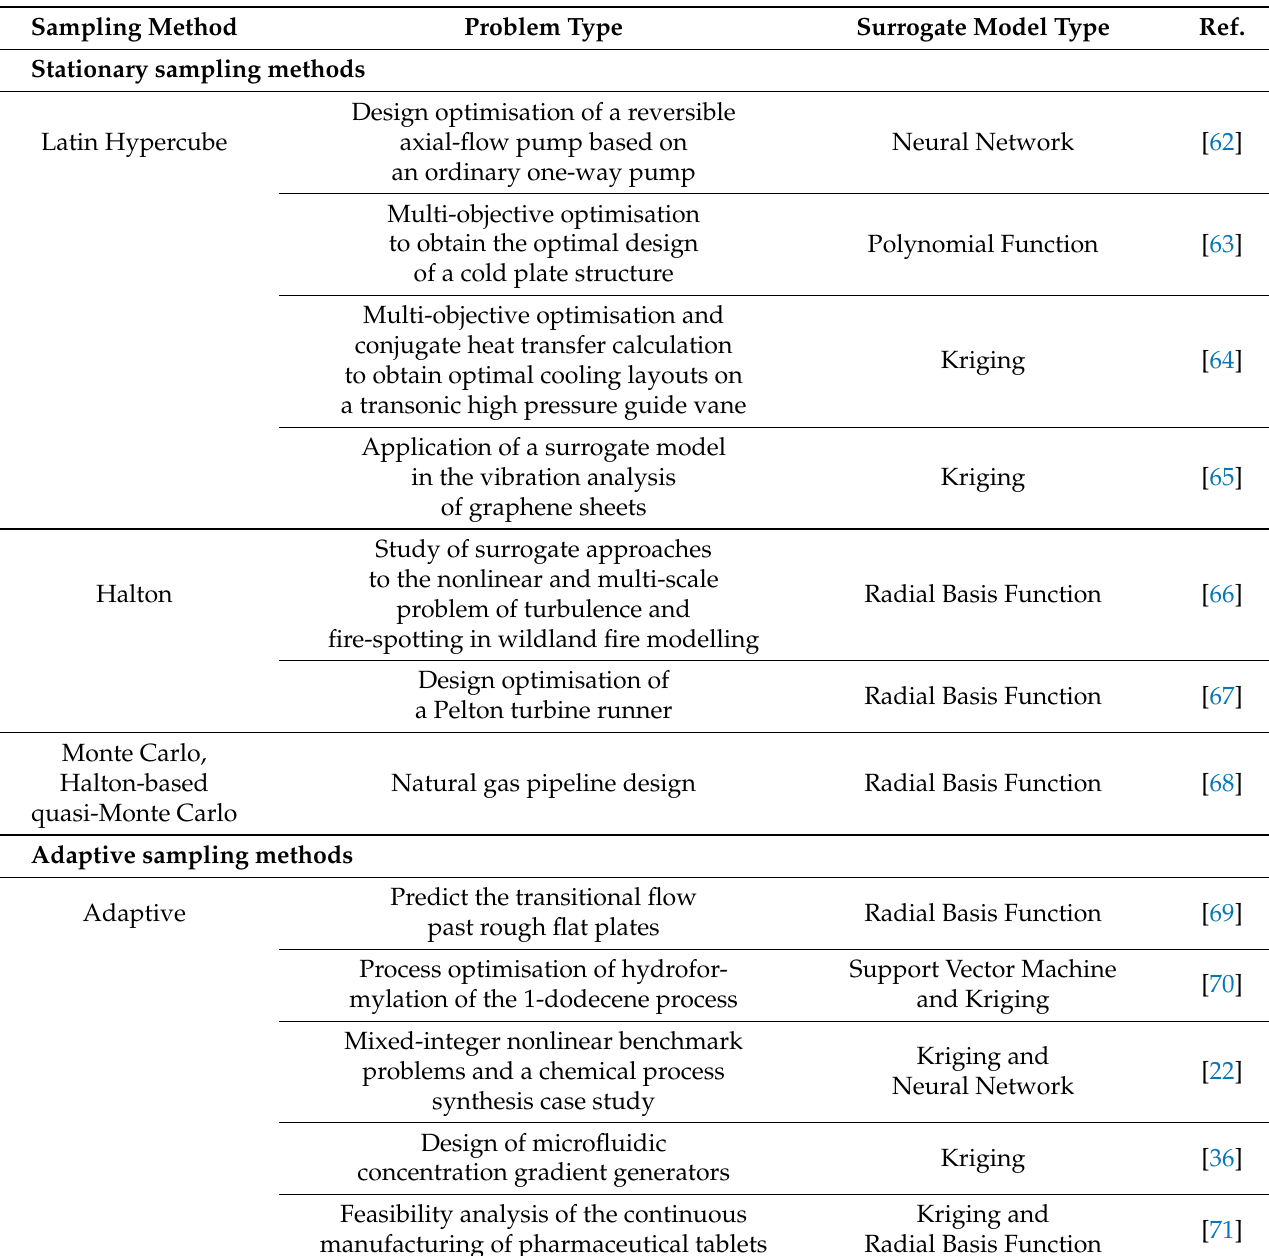
Table 4. The applied sampling methods and surrogate model types for different application